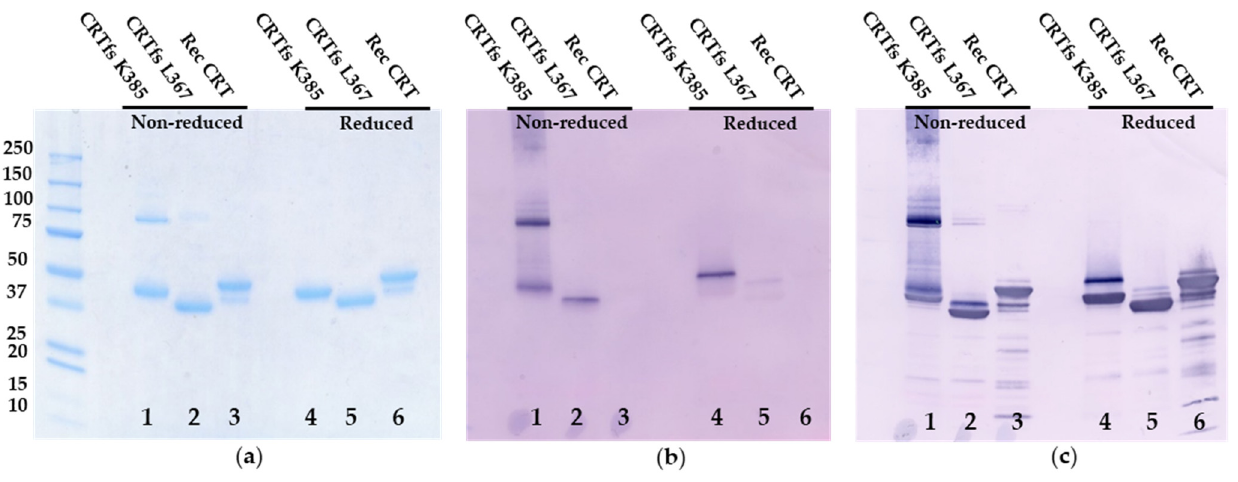
Figure 8. Immunostaining of SSI-HYB 385-06 reactivity to frameshifted calreticulin (CRTfs) and wild-type calreticulin (CRTwt). ( a ) Coomassie Brilliant Blue staining of recombinant CRT proteins. ( b ) Western blotting of SSI-HYB 385-06 reactivity to CRTfs L367 and K385 and CRTwt. ( c ) Western blotting of membrane from figure ( b ) developed with a commercial monoclonal antibody (CRT FMC 75 mAb), recognizing amino acids 34–41 (TSRWIESK) in the N-terminal of CRT. Lane 1: non-reduced CRTfs K385, Lane 2: non-reduced CRTfs L367, Lane 3: non-reduced recombinant CRT, Lane 4: reduced CRTfs K385, Lane 5: reduced CRTfs L367, Lane 6: reduced recombinant CRT.